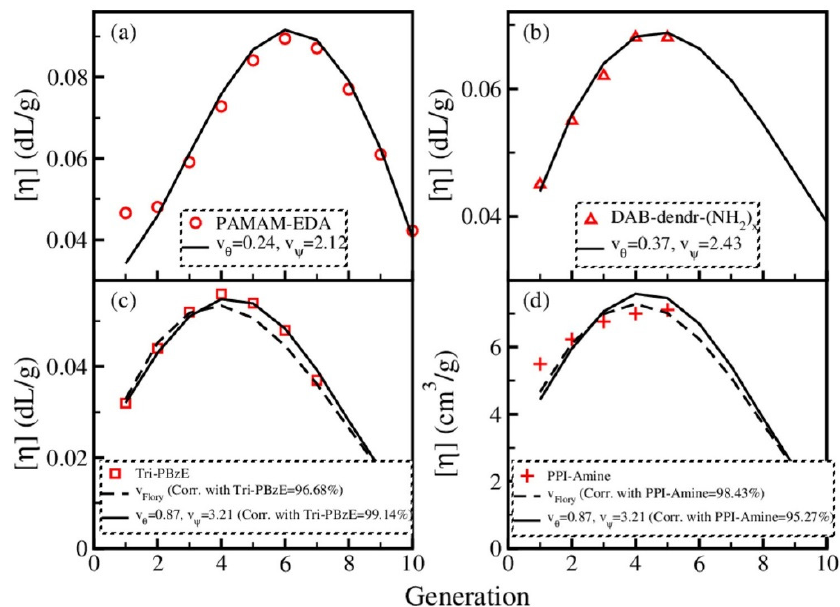
Figure 2. Plots of the experimental and calculated intrinsic viscosity [ η ] for different dendrimers as a function of generation. The experimental results are for PAMAM dendrimers with an EDA core ( a ) [1], for an amino-terminated PPI dendrimer with a DAB core, indicated as a DAB-dendr-(NH 2 ) ( b ) [11], for a Tri-PBzE dendrimer ( c ) [8] and for a PPI dendrimer with a DAB core ( d ) [12]. In the panels, ν θ and ν ψ are the two excluded-volume parameters for beads belonging to the same or to the adjacent generation (see the text and Reference [33] for more details), while ν Flory is the parameter estimated